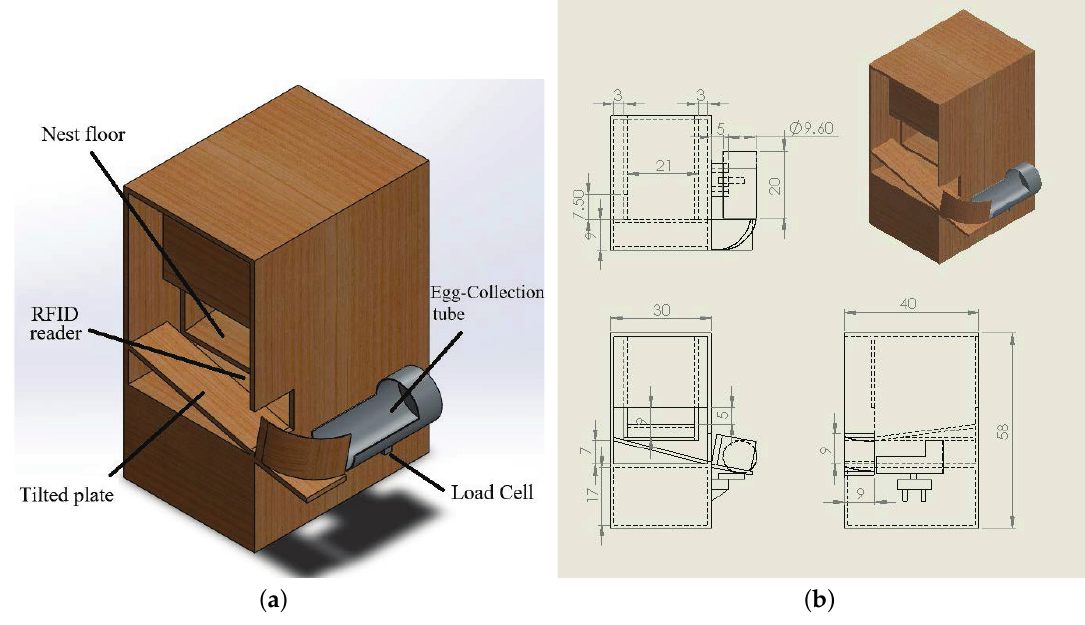
Figure 1. Design of Smart Nest Box (of 30 cm (W) × 40 cm (D) × 58 cm (H)). ( a ) Design drawing; ( b ) dimensional drawing.